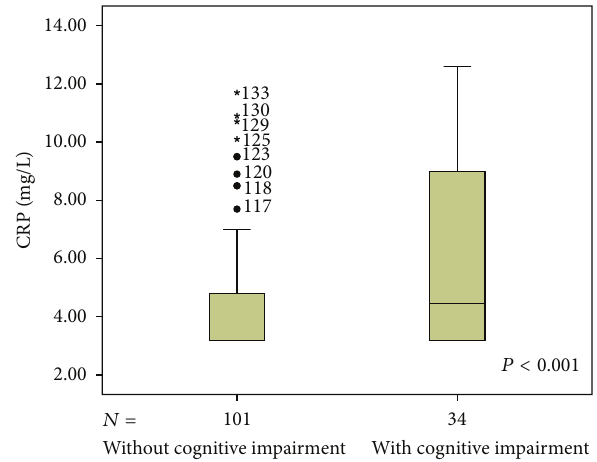
Figure4:CRPleveldistributioninthosewithoutandwithcognitive impairment. Mean CRP with cognitive impairment: 5.81; mean CRP adjusted for covariates: 5.7; 𝑃 < 0.001 . Mean CRP without cognitive impairment: 4.33; mean CRP adjusted for covariates: 4.7; 𝑃 < 0.001 . CRP: C-reactive protein.